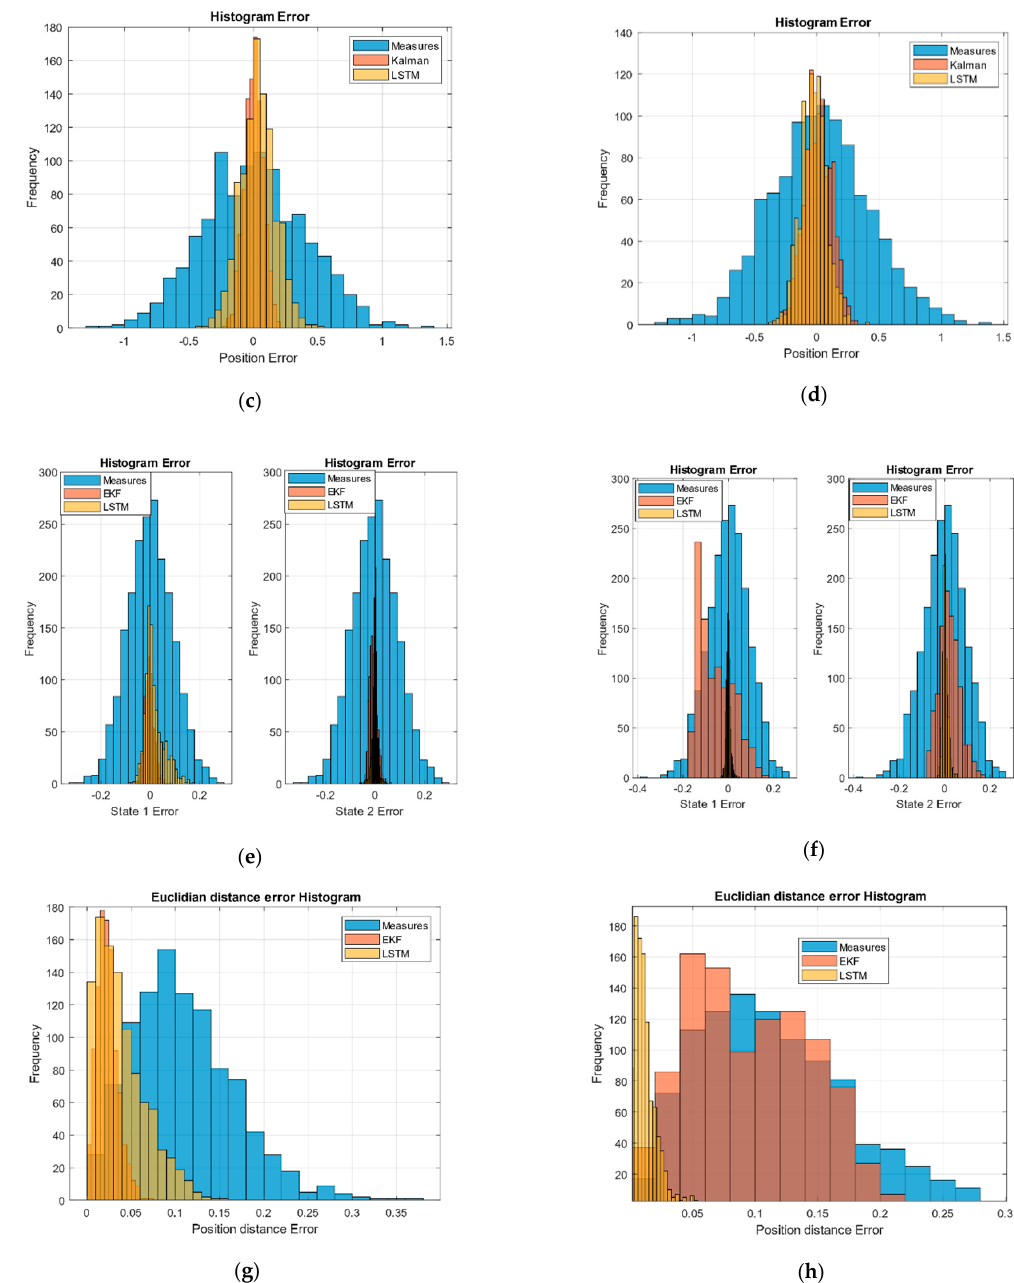
Figure 2. Long short-term memory (LSTM) and Kalman histogram validation: ( a ) first and ( b ) second, checkpoint in the URM model. ( c ) First and ( d ) second checkpoint in the sinusoidal path model. ( e ) First and ( f ) second checkpoint in the Volterra system paths. ( g ) First and ( h ) second checkpoint in the Volterra system (Euclidean distance error). Table 5. Kalman and LSTM validation results.